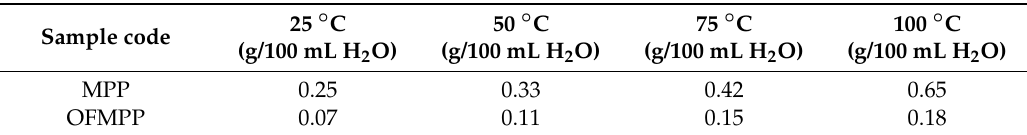
Table 2. Water solubility data of MPP and